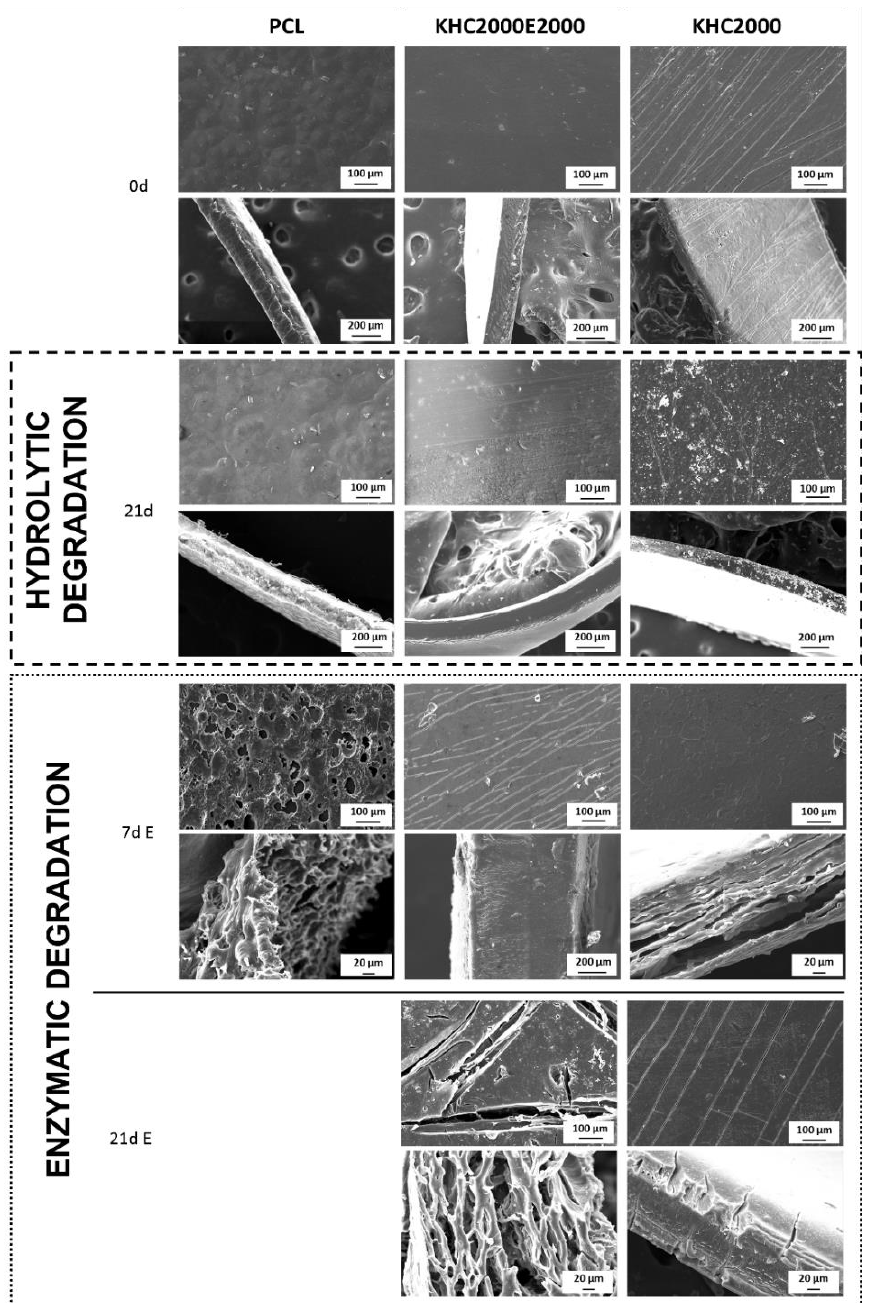
Figure 3. SEM micrographs of the surface and cross-section of PCL, KHC2000, and KHC2000E2000 films before degradation onset (0d) and after hydrolytic degradation in PBS at 37 ◦ C for 21 days and enzymatic degradation in PBS added with lipase at 37 ◦ C for 7 and 21 days (on day 21 PCL sample was not analyzed due to its complete